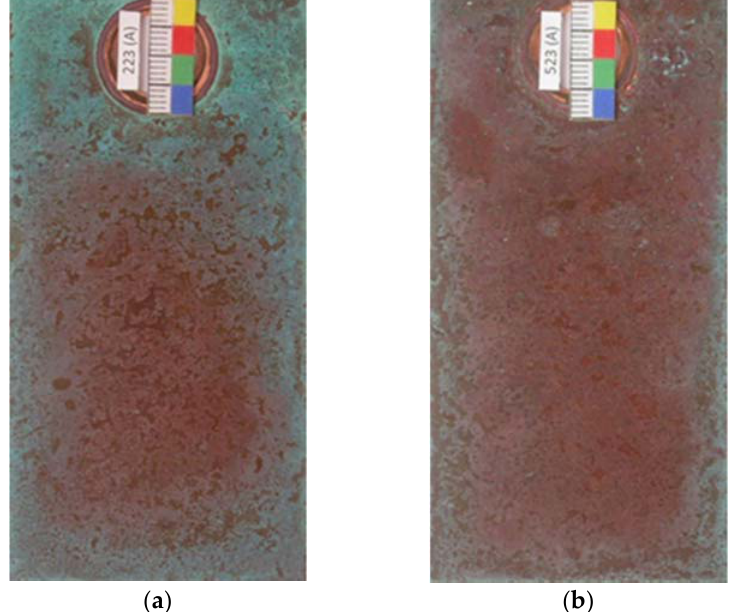
Figure 6. Early formation of basic copper chlorides at the edges of the test specimens ( a , b ) and in areas around the fastening clips ( a ) due to greater moisture retention and a higher saline concentration in the precipitated aqueous layer as a result of evaporation during the drying period. Table 5. Evolution with exposure time of the percentage coverage of the cuprite patina by basic copper chlorides. Information corresponding to the seaward facing specimen side at the different testing